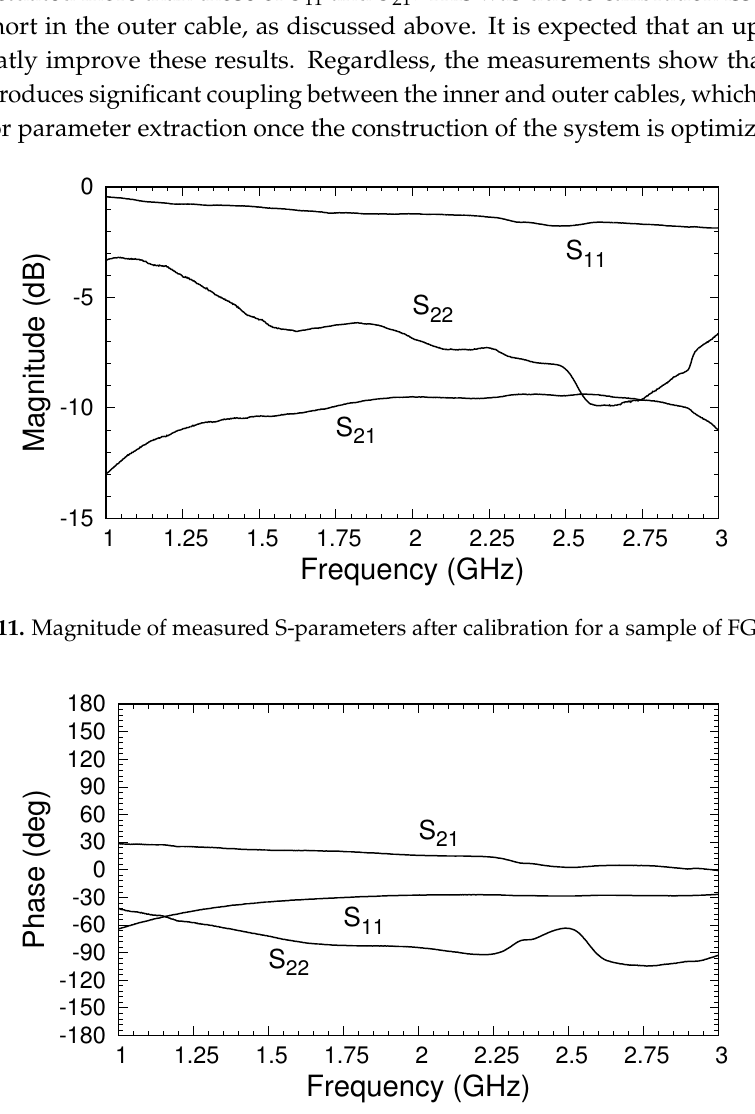
Figure 12. Phase of measured S-parameters after calibration for a sample of